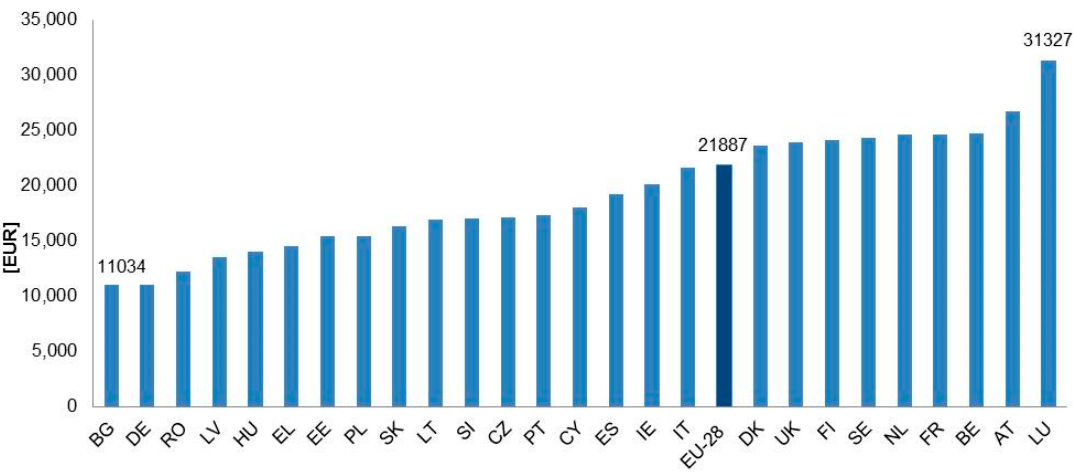
2016. Source: Eurostat. Figure 10. Adjusted gross disposable income in the purchasing power standard per capita in the EU-28,